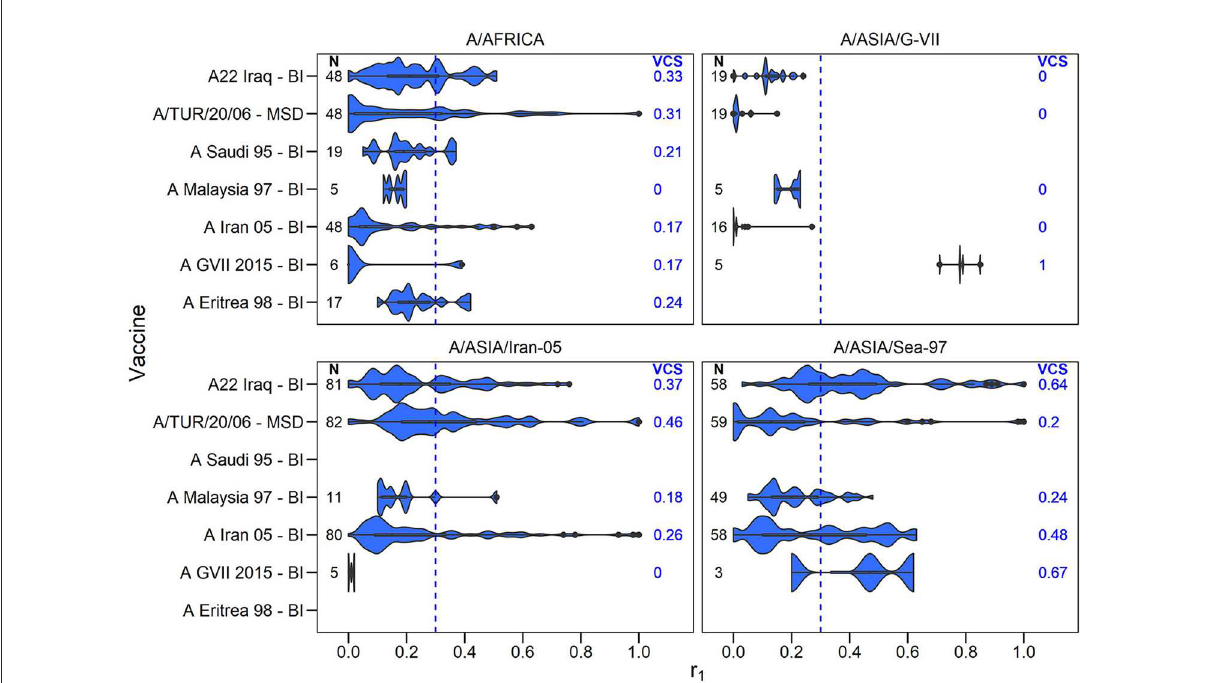
FIGURE3 Violin plots showing results of vaccine matching tests performed at the WRLFMD between 2011 and 2021, for each vaccine/lineage combination for serotype A. Resulting vaccine coverage scores are labeled on the right in blue, and the number of tests performed are labeled on the left in black. Blue dashed line shows the cut off of 0.3 r 1 indicative of an effective vaccine